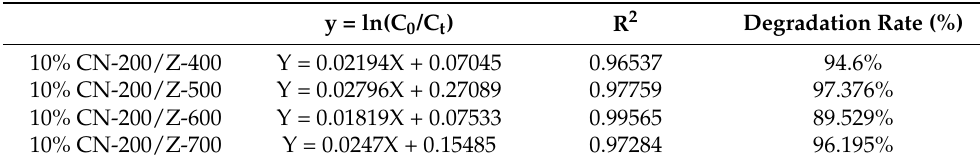
Table 1. Degradation rate of MB after compound of zinc oxide and CN prepared at different anneal- ing temperatures.